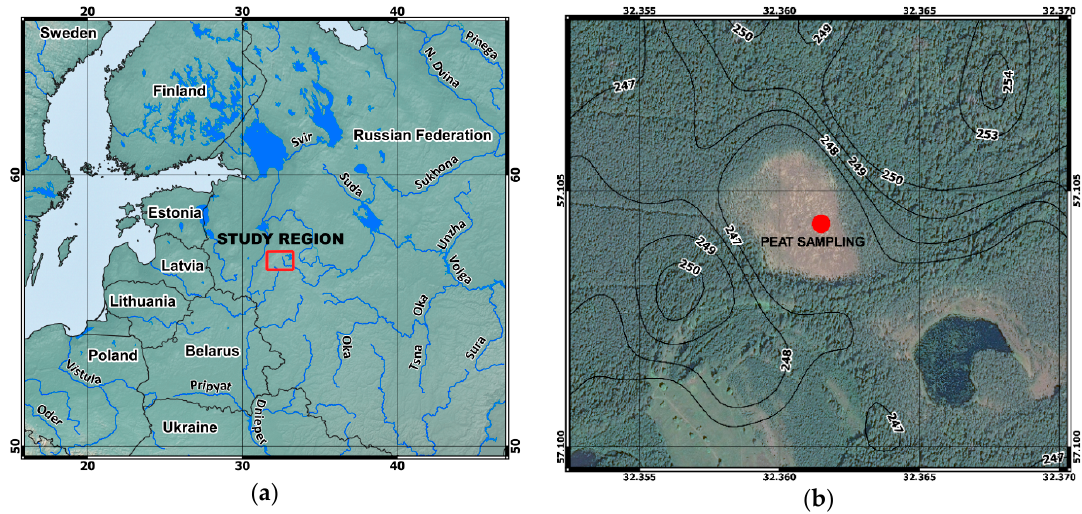
Figure 1. ( a ) Map of the study region (source: http://freegisdata.rtwilson.com) and ( b ) the study site (source: Yandex.Maps service). Elevation lines are created with a resolution of 1 m based on SRTM 1 arc-second global (source: https://earthexplorer.usgs.gov).